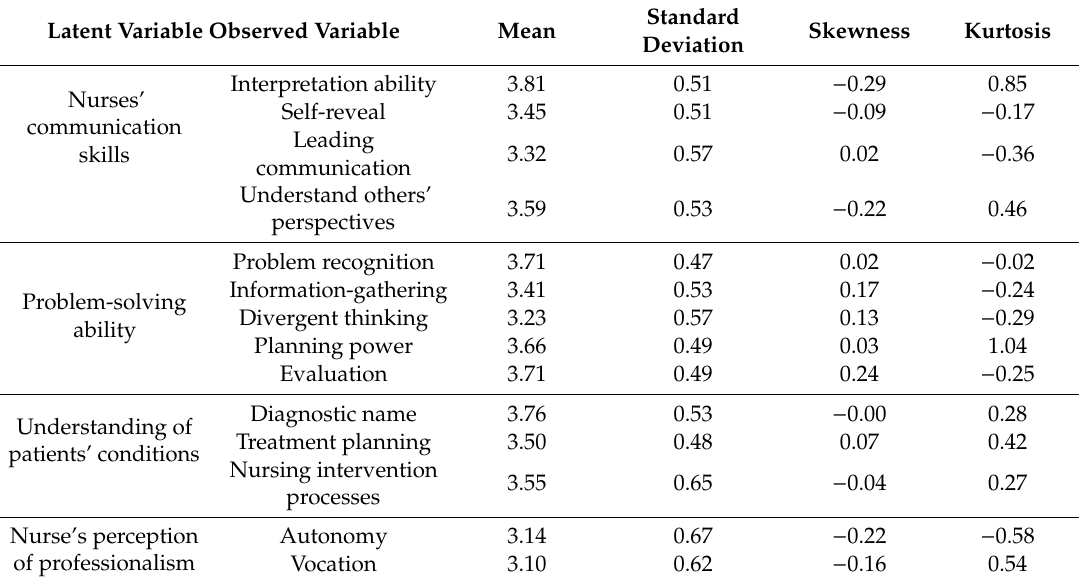
Table 2. Technical metrics of the measurement variables ( N = 171).